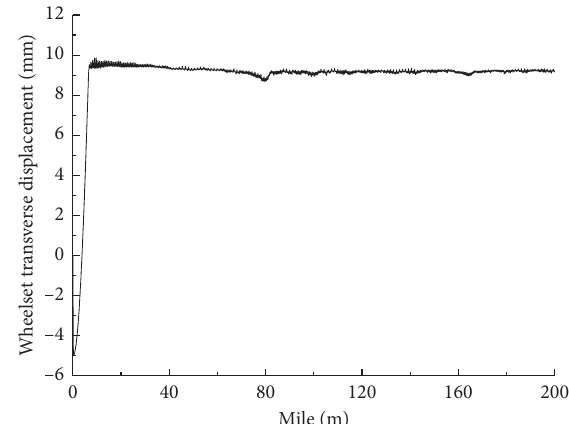
Figure 9: Transverse displacement of the wheelset.